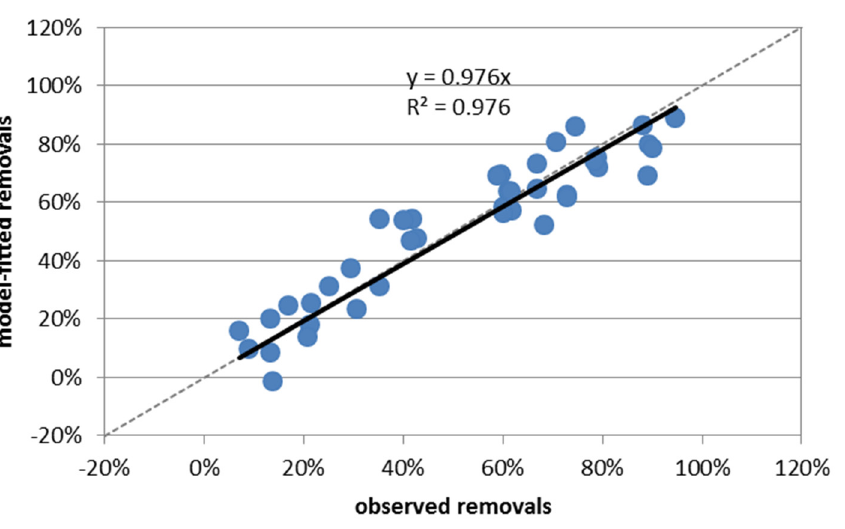
Figure 5. Observed removals versus model-fitted removals (five parameters model, 21 h batch adsorption).